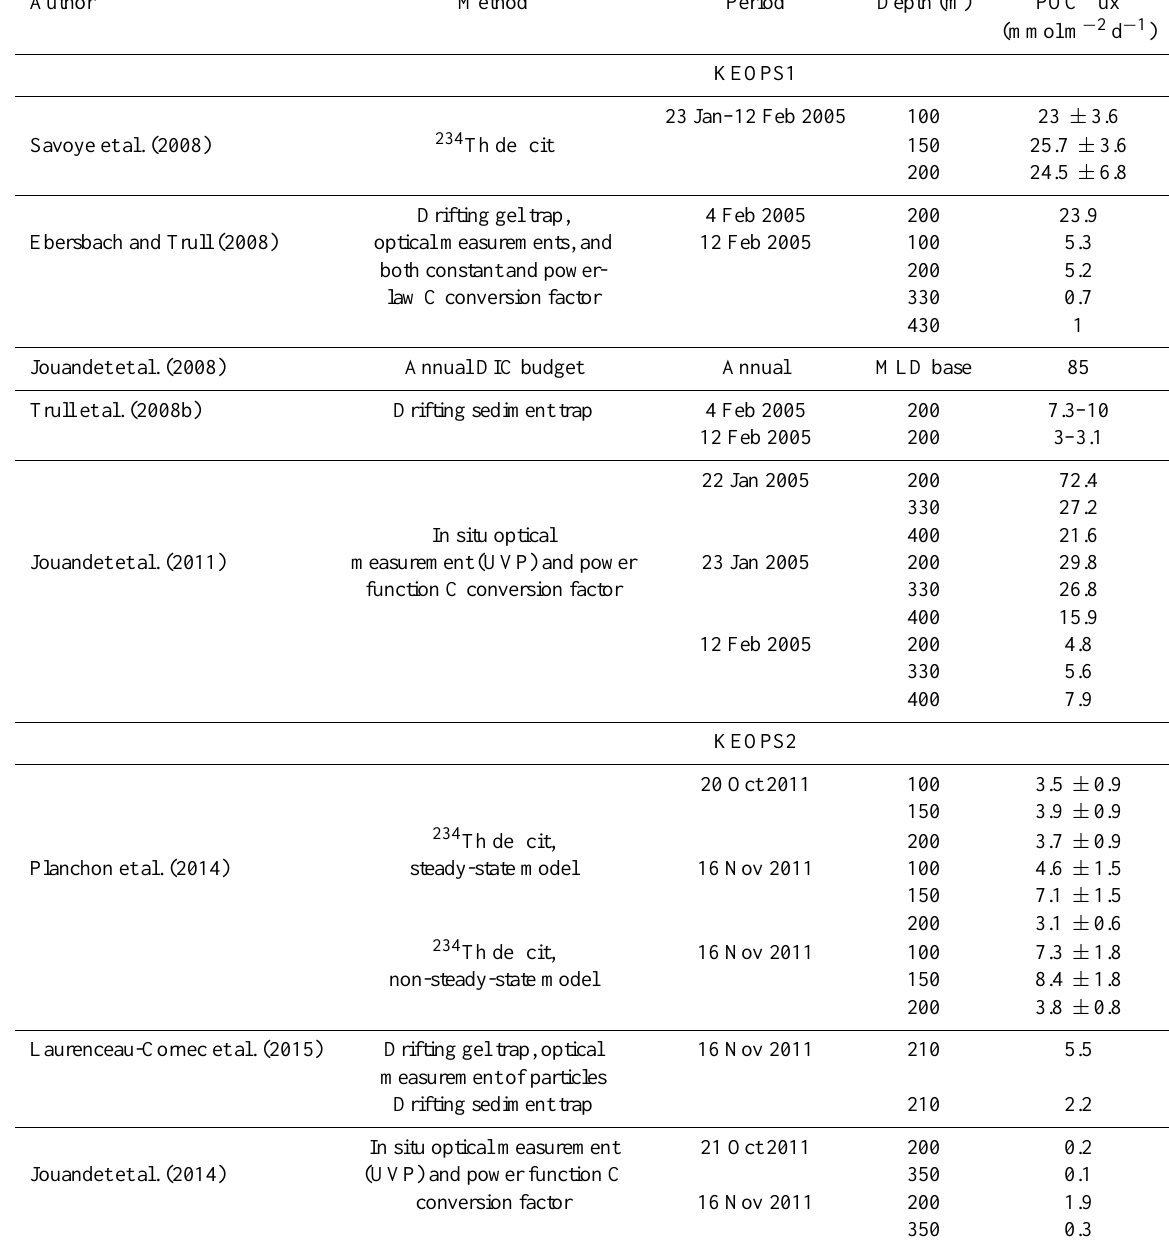
Table 3. Summary of estimates of POC fluxes at the base of, or under, the mixed layer at station A3 from the KEOPS cruises.